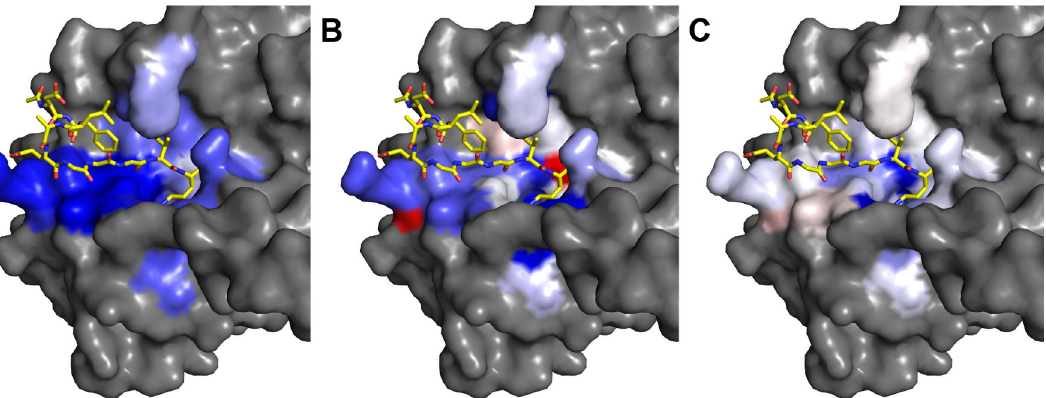
Fig 4. Dynamics changes upon fibrinogen binding to thrombin. Residue-wise mapping of flexibility difference maps Thr com,Fib — Thr holo,Fib with colors ranging from blue (complex more rigid than holo) over white (no change) to red (complex more flexible than holo). Rigidification on substrate binding is shown for global backbone B-factors (A). For φ entropy (B) rigidification of some parts on complex formation is shown. A slight mobilization of Leu-99 is observed. For ψ entropy (C), no significant binding site rigidification apart from the S1 and S2 sub-pocket is